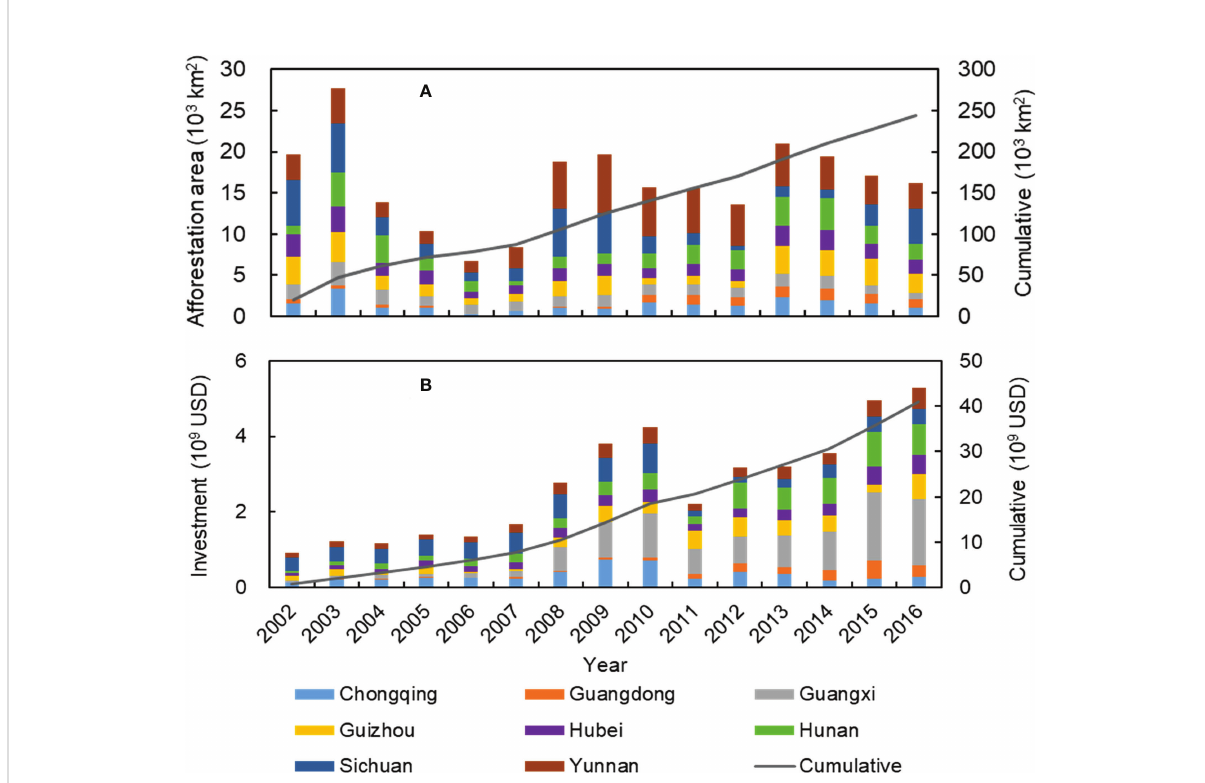
FIGURE 6 Annual (left y-axis) and cumulative (right y-axis) afforestation area and forestry investment in the eight provinces in southern China from 2002 to 2016. (A) Afforestation area, and (B) forestry